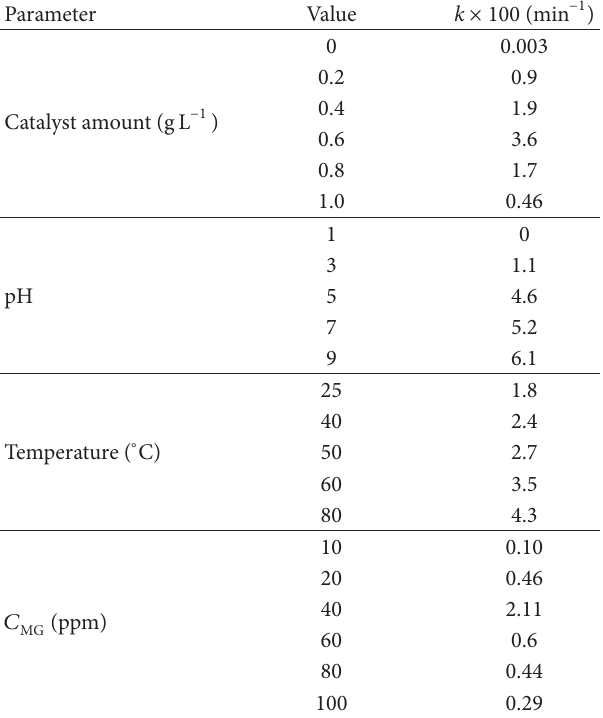
F 6: Effect of Ni-DMG/ZSM-5 dosage on the decolorization efficiency of MG dye; initial dye concentration, 20ppm; initial pH, T 1: Rate constant values as a function of various experimental parameters.